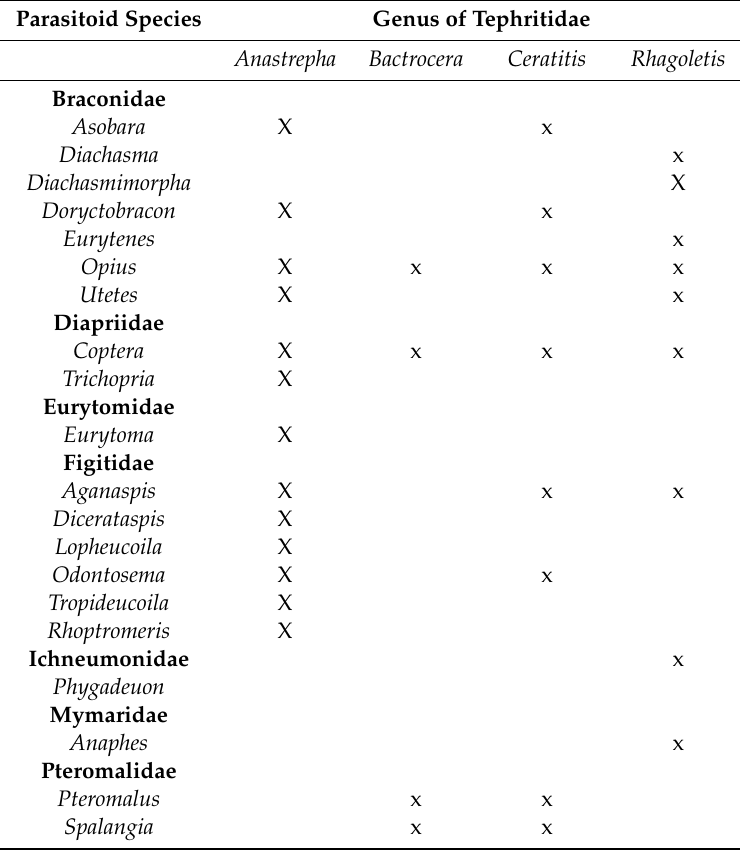
Table 1. Association between the genus of native parasitoids (Hymenoptera) and the genus of fruit flies with economic importance in the